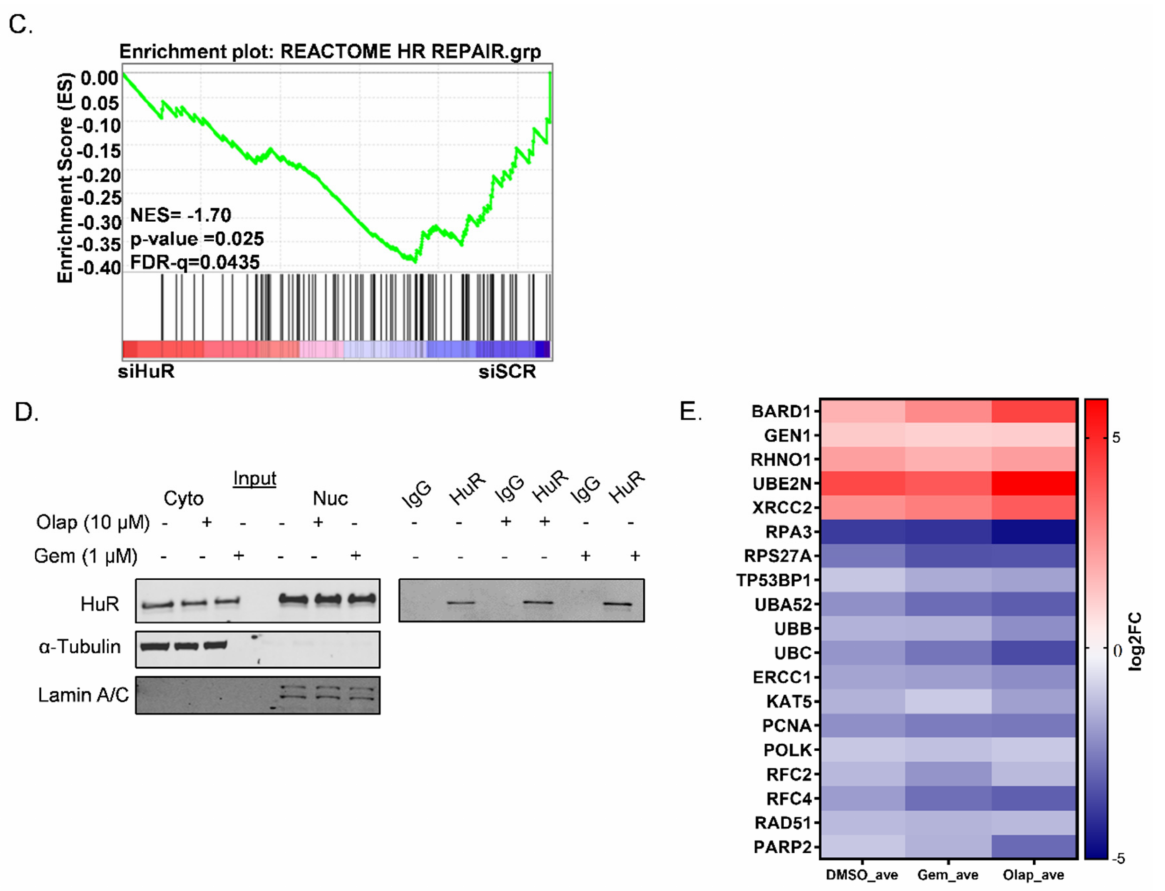
Figure 1. HuR regulates homologous recombination repair in PDAC cells. ( A ) Comet assay showing an increase in DNA damage when MiaPaCa-2 cells were transfected with siHuR (siHuR#1) as compared with the siSCR control. H 2 O 2 was used as a positive control (the scale bar: 10–50 µ M). Mean ± SEM, n = 3. **** p < 0.0001 (Student’s t -test). Validation of HuR knockdown is shown on the right. ( B ) pDR-GFP assay: MiaPaCa-2-DRGFP cells were transfected with siHuR (siHuR#1) and 24 h later they were re-transfected with pCBASceI (10 µ g). Graph shows the percentage of HRR efficiency by comparing siHuR and siSCR, as calculated by quantitating GFP-positive cells using flow cytometry. Mean ± SEM, n = 3. * p < 0.05, ** p < 0.01 (Student’s t -test). Validation of HuR knockdown is shown on the right. ( C ) Gene set enrichment analysis of siHuR (HuR_NT) vs. siSCR (CTRL_NT) ( n = 4) samples in MiaPaCa-2 cells, showing negative enrichment of the Reactome homologous recombination repair pathway. ( D ) Western blot showing validation of HuR fractions in cytoplasmic and nuclear compartments; and HuR-IP in MiaPaCa-2 cells. α -Tubulin was used as a control